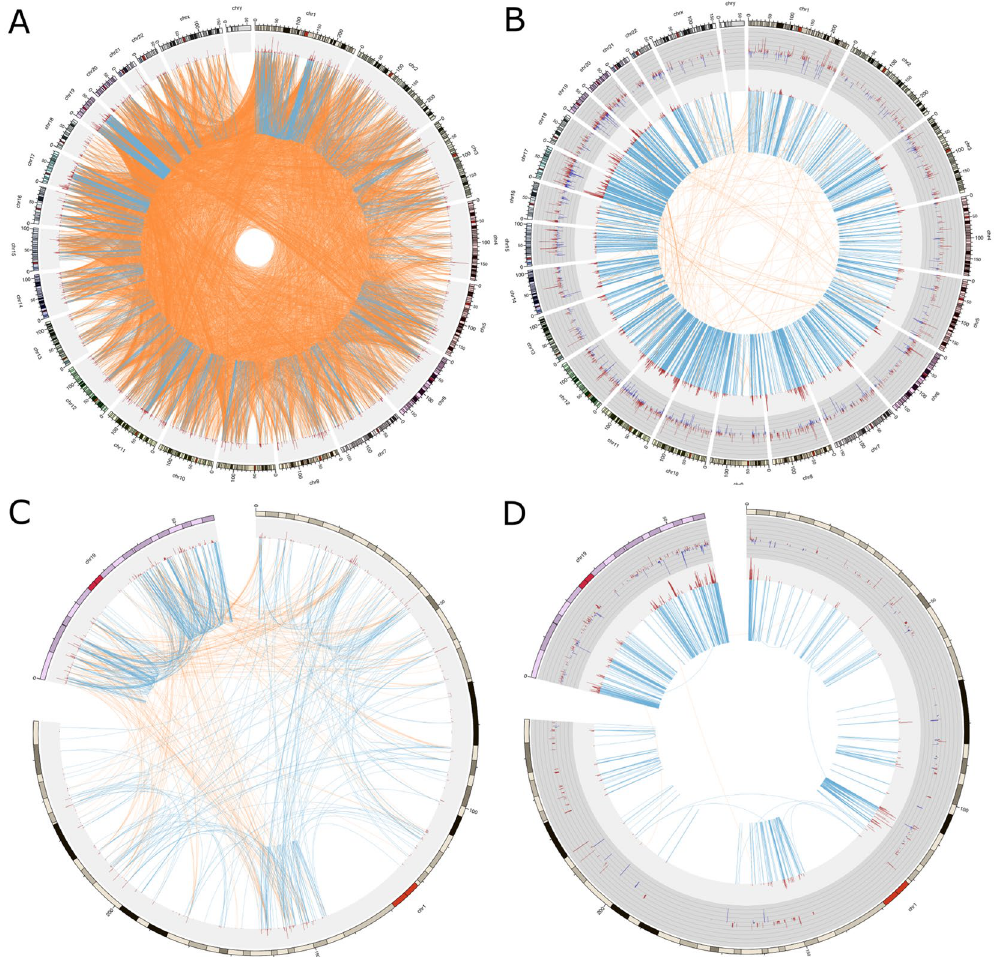
Figure 3. Inter-chromosomal regulation loss. The circos plots show the dramatic difference in the connectivity of healthy network (HN) and cancerous network (CN). ( A ) The HN using the top 0.01% mutual information (MI) values. The blue lines represent gene intra-chromosomal relationships. Orange lines join inter- chromosomal genes. The next outer circle (grey) represents the degree of each gene (number of neighbours of each gene) as red peaks height proportional to its degree. The external circle indicates the chromosomal location where regions are separated by squares. Notice in panel (A) the high density of the inter-chromosomal relationships (around 11,000 edges). On the contrary, in panel (B) the CN has a high density of intra- chromosome relationships, meanwhile, the inter-chromosome links are almost absent. It is worth to mention that both networks contain the same number of links. In panel (B) it is also depicted in a dark-grey circle, the differential expression of its genes: blue/red histograms indicate under/overexpression respectively. The size of the line is proportional to the differential expression value. Panels (C and D) are a zoom-in for HN (panel C) and CN (panel D) of chromosomes 1 and 19, which shows a remarkable difference in the chromosomal distance between edges. In panel (C) genes are linked to Chr19 but are not close between them, meanwhile, for panel (D) the majority gene relationships takes place within its